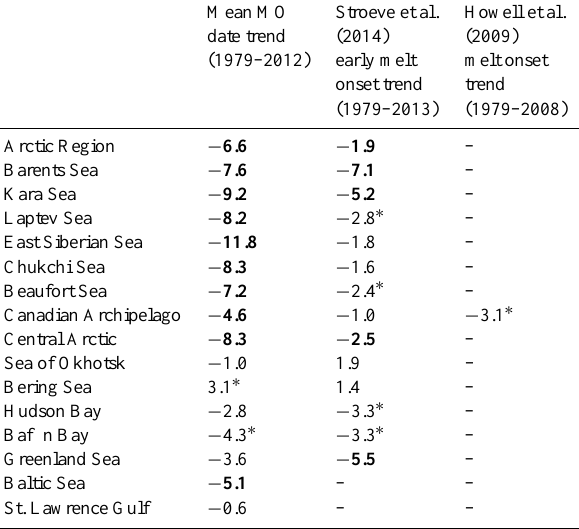
Table 2. Comparison of trends in V3 mean MO date with other reported trends (in daysdecade − 1 ). Numbers in bold indicate sta- tistical